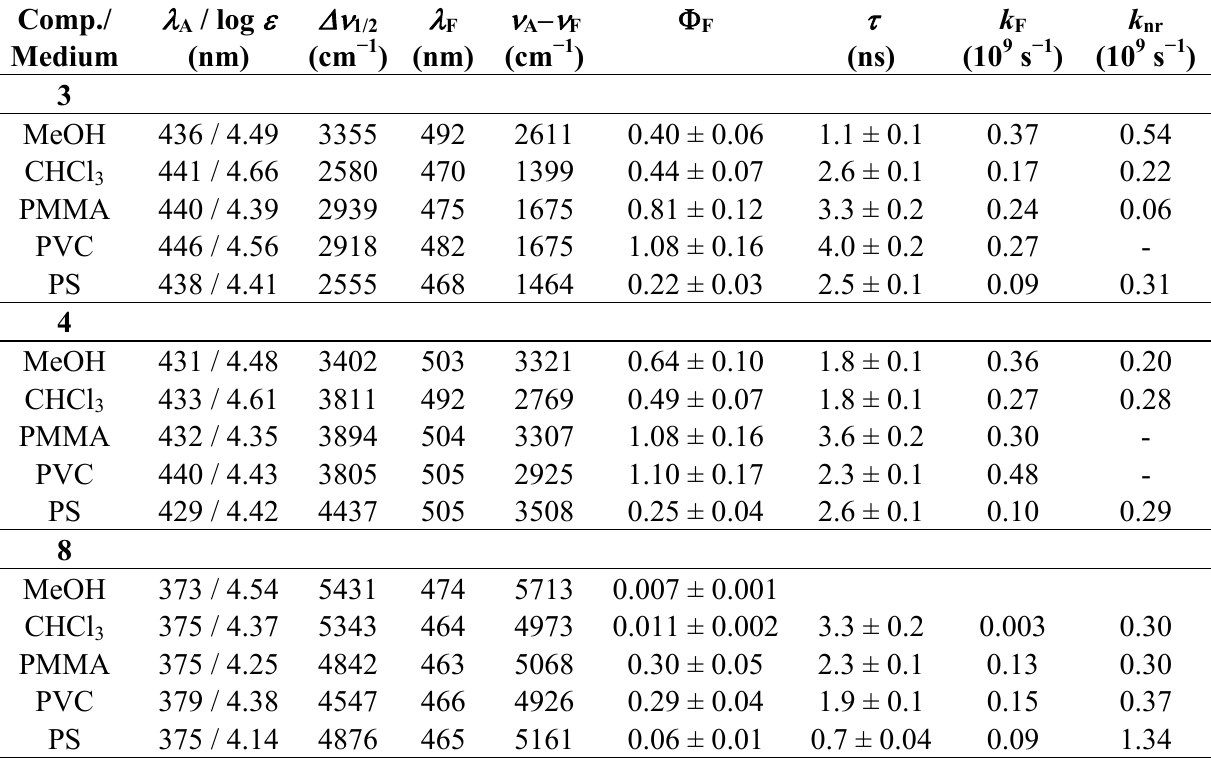
Table 2. Spectral properties of disubstituted derivatives of coumarin 3 , 4 and 8 .